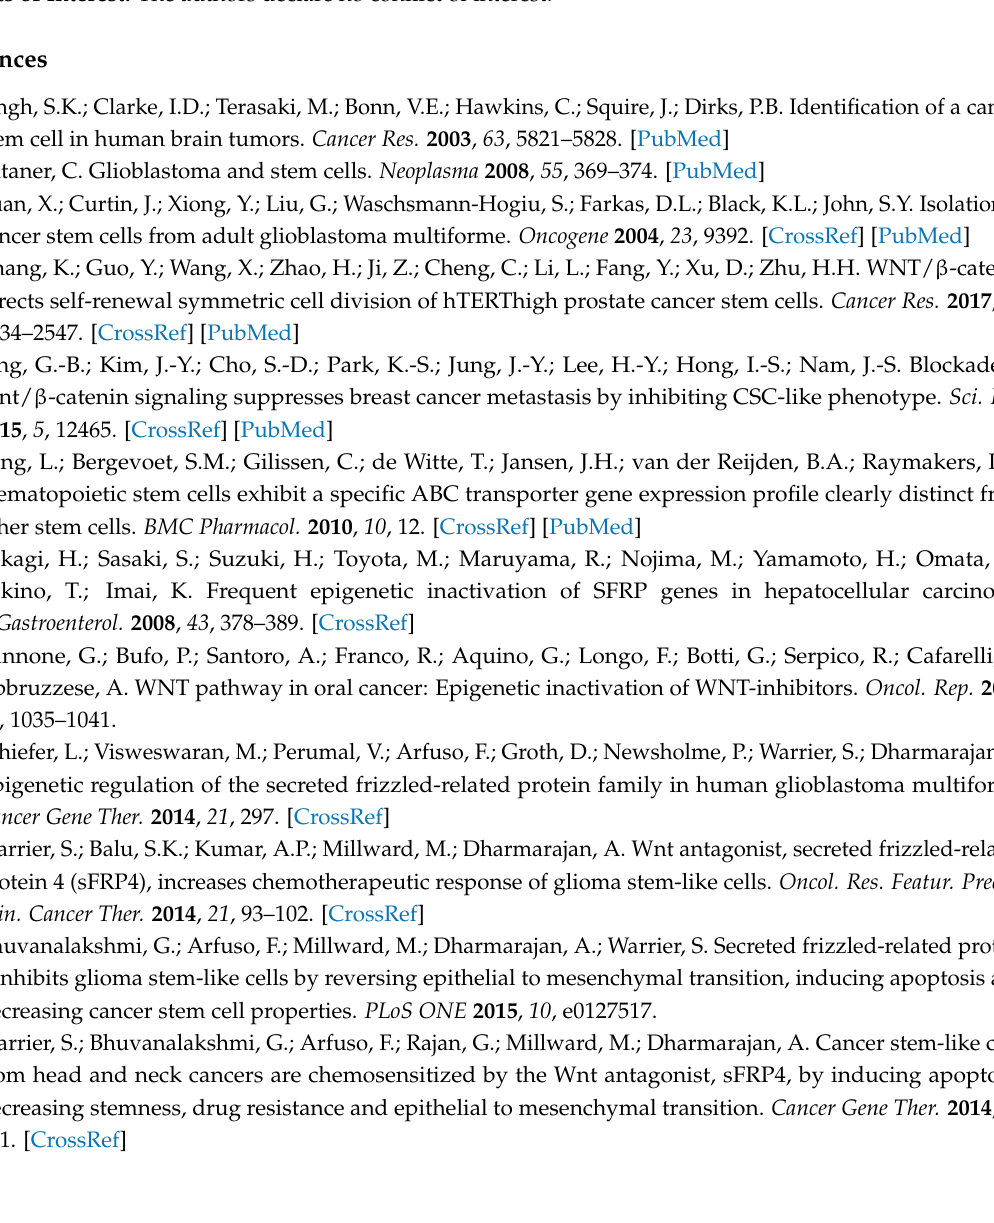
Table S2: Primers used in Real-Time